Question: Provide a one-line summary of what is displayed.
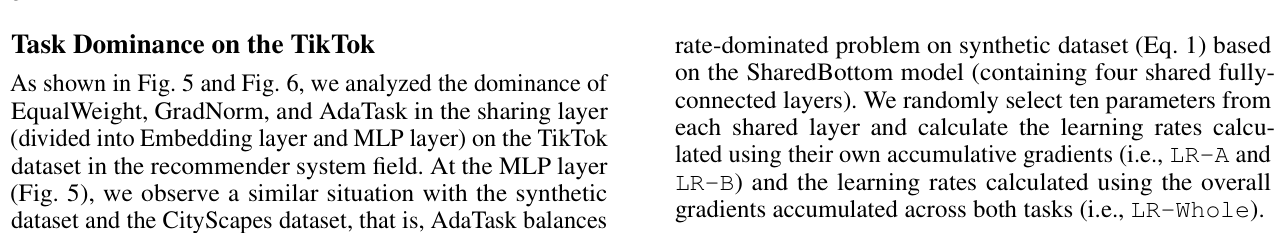
Answer: Illustration of learning rate dominance of randomly sampled parameters from the 1st to 4th layer for two MTL methods: (a) EqualWeight and (b) our AdaTask. The learning rate of Task A (i.e., LR-A) or Task B (i.e., LR-B) is based on Task A’s or Task B’s own accumulative gradient, respectively. The whole learning rate (i.e., LR-Whole) is based on the sum of accumulative gradients from both tasks.